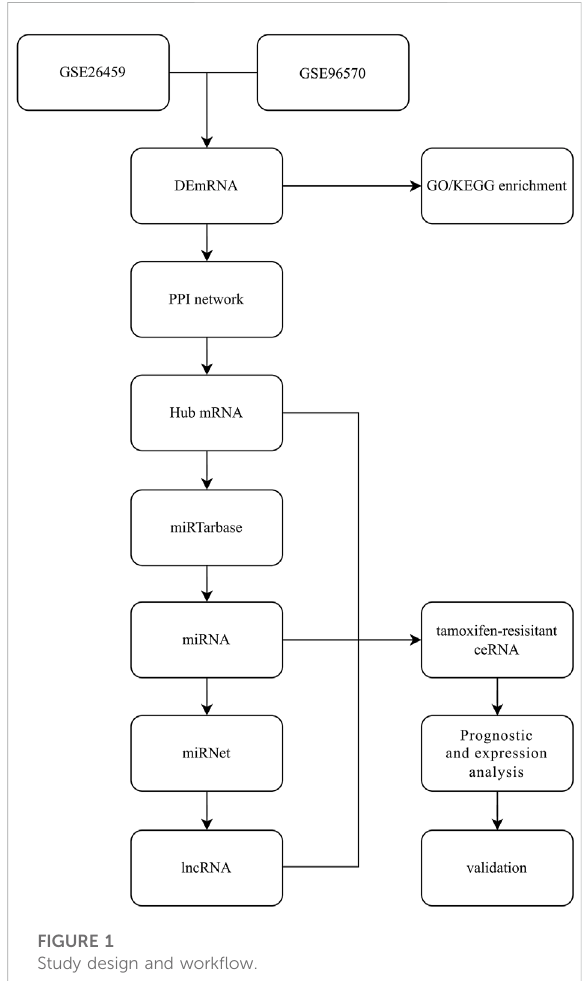
FIGURE 1 Study design and work fl